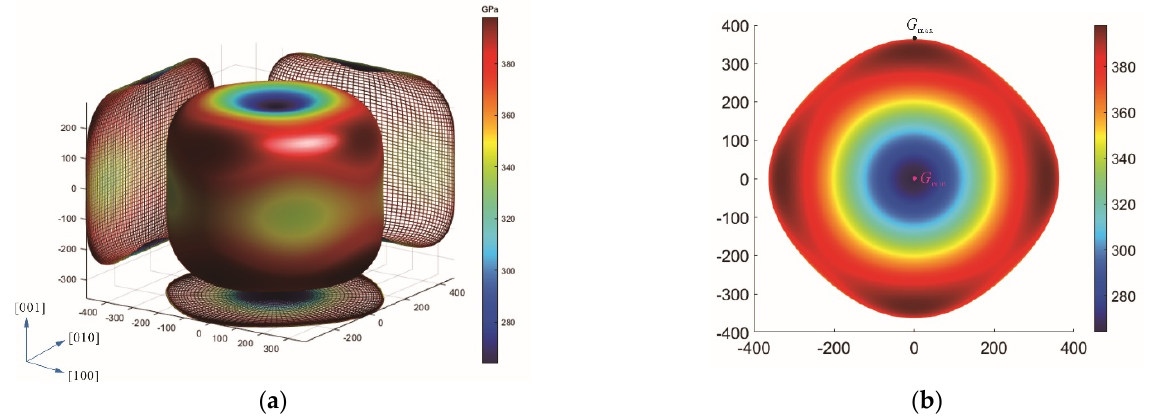
Figure 2. Schematic diagram of each vector l in the lattice space. A three-dimensional diagram of the elastic modulus of the Mo 5 SiB 2 single crystalsis shown in Figure 3a. The isosurface of the elastic modulus was projected onto the crystal plane (001), as shown in Figure 3b. The maximum Young’s modulus of the Mo 5 SiB 2 single crystals was obtained at the vertex of the crystal direction of [010], with E max = 398.0 GPa. The minimum value was obtained in the crystal direction of [001], with E min = 264.0 GPa. Figure 3. Elastic modulus of Mo 5 SiB 2 single crystals: ( a )